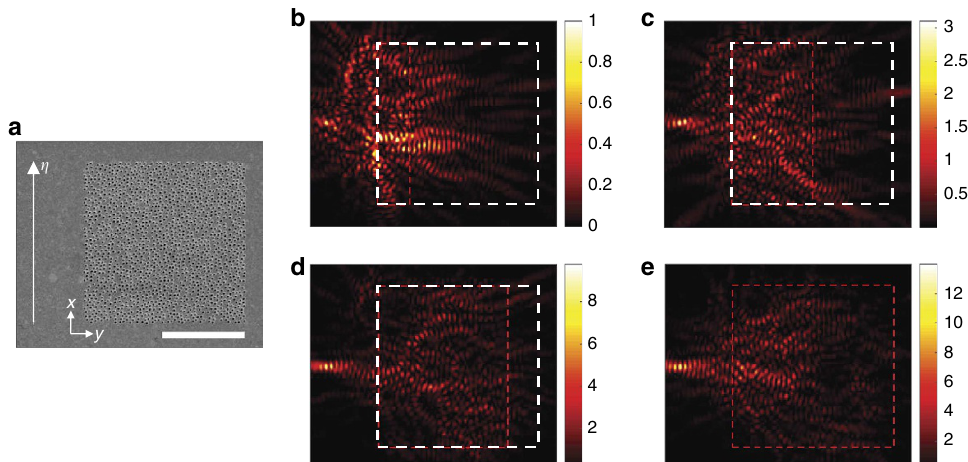
Figure 3 | Experimental demonstration of SPP focusing. ( a ) Photograph of a 2D disordered array of nanoholes patterned on Au film taken by the scanning of a focused ion beam. The positions of the individual holes are described by the coordinates x and y , and Z indicates a coordinate along the sampling line. ( b – e ) Intensity maps for SPPs imaged at the camera when the phase maps of far-field illumination were set to maximize the intensity of the SPPs at a specific target spot on the sampling line (see main text for the identification of the appropriate phase maps). The width of illumination was W ¼ 2, 5, 8 and 10 m m for ( b – e ) respectively. The white rectangular box shows the boundary of the array of nanoholes. The red rectangular box indicates the area where the far-field waves illuminated. The colour bars indicate the intensity in arbitrary units on the same scale for ( b – e ). Scale bar, 5 m